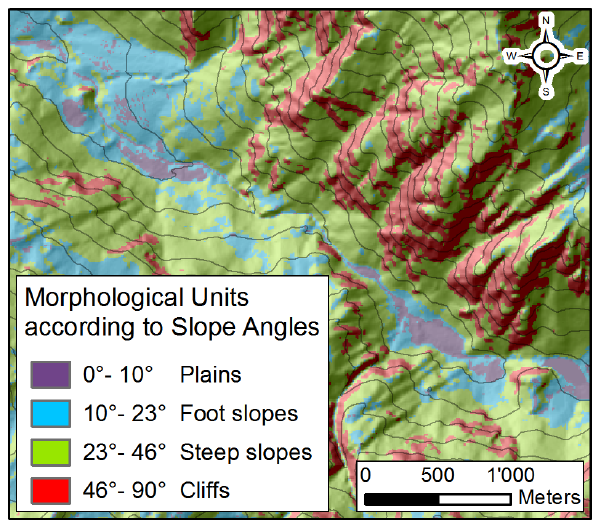
Fig. 4. Example of main morphological units in a region of the Bagnes valley according to slope angle thresholds got thanks to the SAD procedure. (Hillshade and 10m isohypses: ©2008 swisstopo).